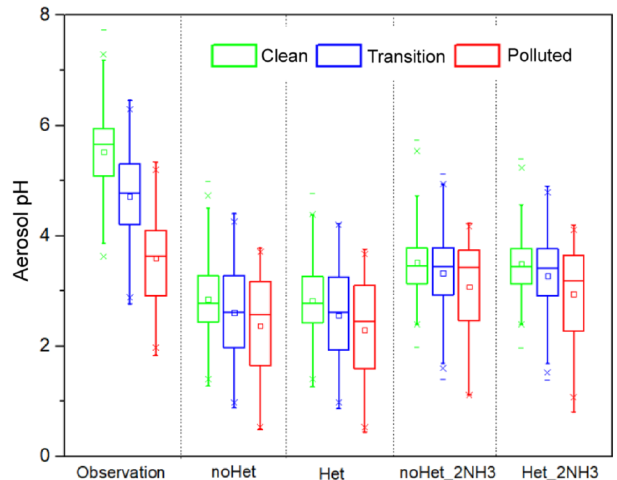
Figure 8. Box and whisker plot of observed and predicted aerosol pH by scenario and